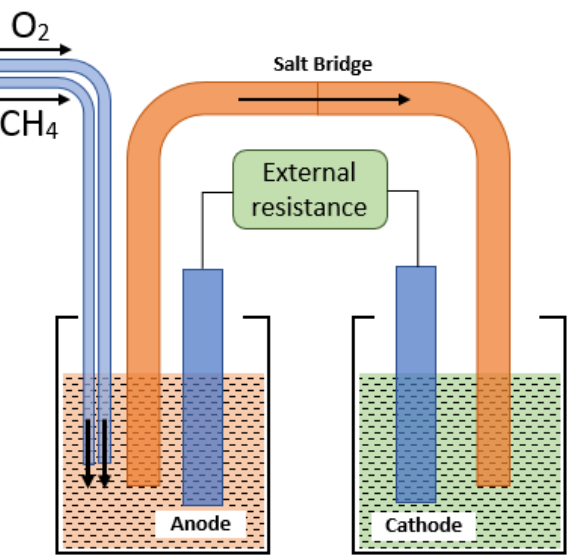
Figure 1. Schematic representation of the microbial fuel cell setup.